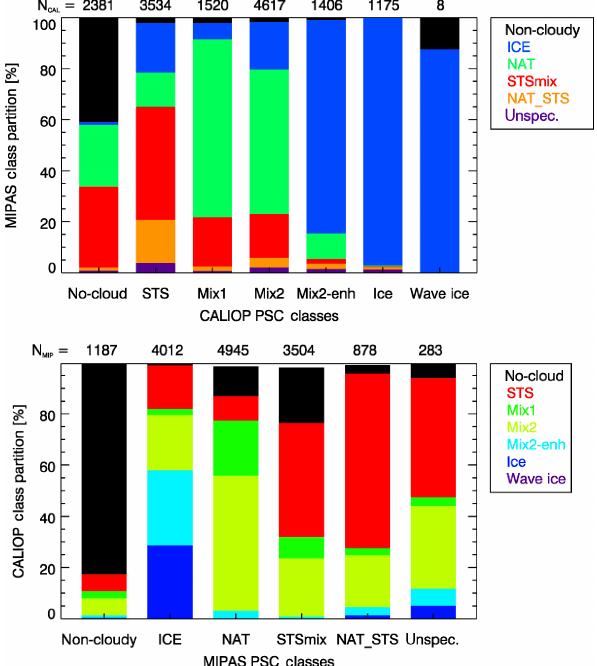
Figure 15. The MIPAS–CALIOP coincidence count statistics of the mean SH winter seasons 2009–2011 (May–October). A miss time of (cid:49)t < 2h and miss distance of (cid:49)x < 100km is applied together with the estimation of an MIPAS-like mean CALIOP type, and only observations above 16km are taken into account (for details see text). Top: partitioning of the coincident MIPAS classes for the co- incident CALIOP classification results. Bottom: partitioning of the coincident CALIOP classification for the MIPAS classes. Numbers on top of the coloured bars indicate the number of observations of the corresponding PSC class.